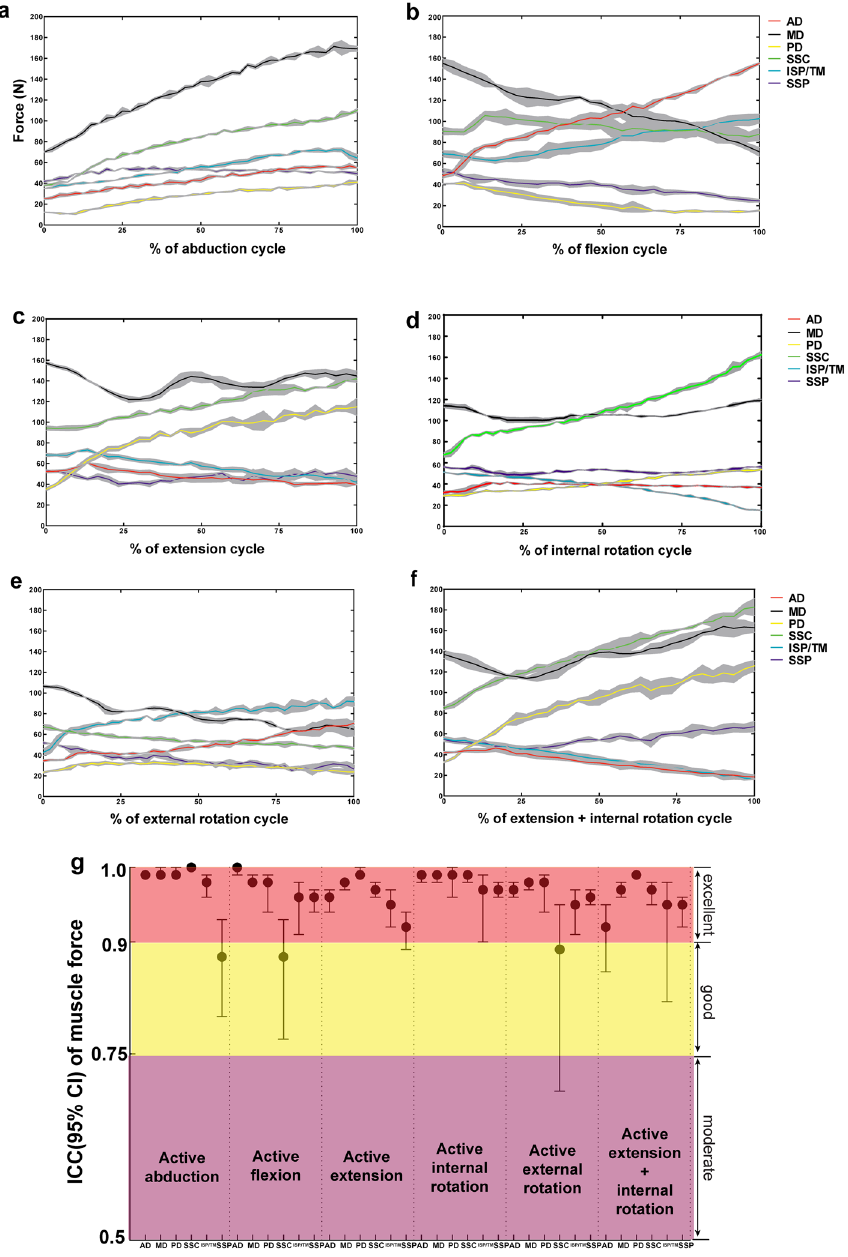
Figure 4. The actuated muscle forces (anterior deltoid, AD; middle deltoid, MD; posterior deltoid, PD; subscapularis, SSC, infraspinatus&teres minor, ISP/TM; supraspinatus, SSP) during active abduction ( a ), flexion ( b ), extension ( c ), internal rotation ( d ), external rotation ( e ) and extension&internal rotation ( f ) cycles (Data from specimen 2). The intraclass correlation coefficient (ICC) of AD, MD, PD, SSC, ISP/TM and SSP muscle forces over the repeated motions are delineated in ( g ) (Data from all three